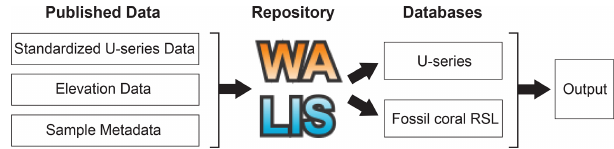
Figure 2. Simplified flowchart of WALIS coral U-series database structure. All coral age, elevation and metadata are included in the “U-series” component of the database, whereas the “fossil coral RSL” database only includes entries from corals that are in primary growth